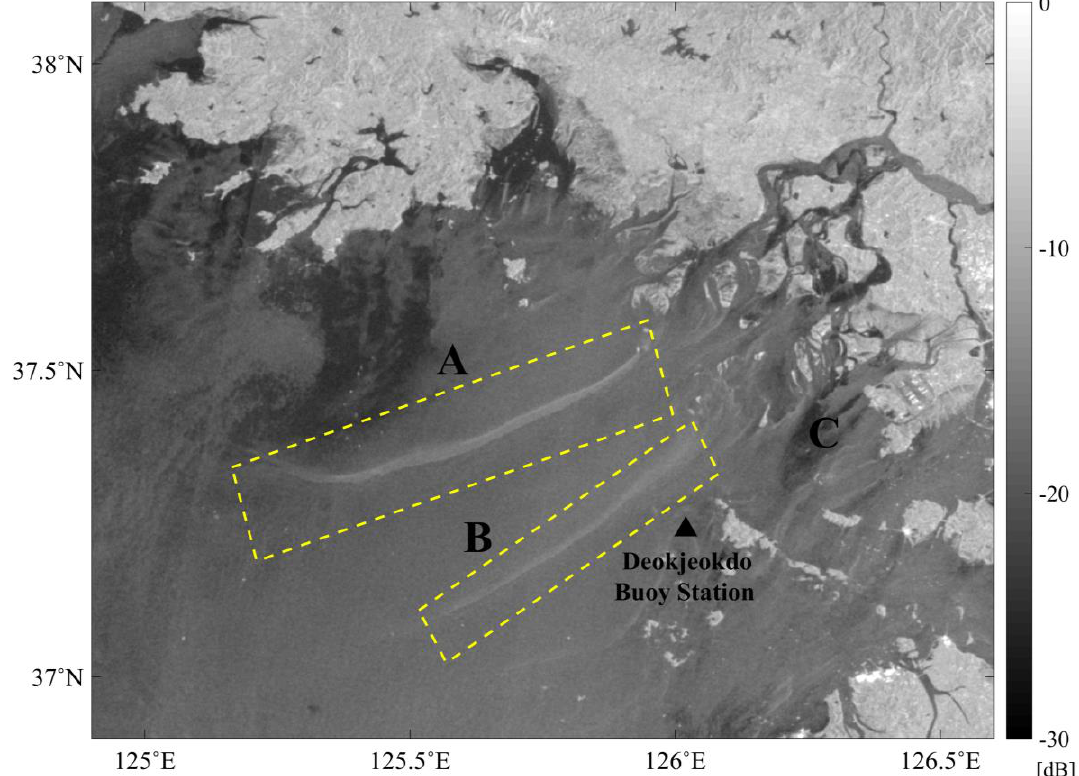
Figure 2. An example of a synthetic aperture radar (SAR) image at the study area off the Western coast of Korea, acquired on 11 December 2007, where the black triangle indicates the Korean Meteorological Administration (KMA) meteorological buoy station.